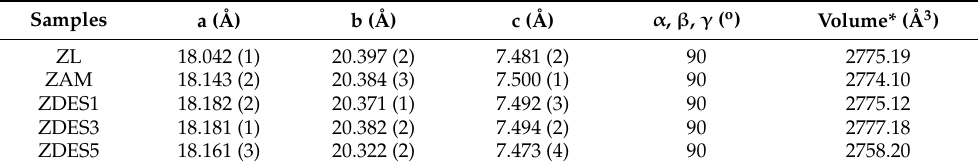
Table 1. Unit-cell parameters and volume of the raw material (ZL); ammonia-exchanged sample (ZAM); and dealuminated samples (ZDES1, ZDES3, and ZDES5) *. Samples